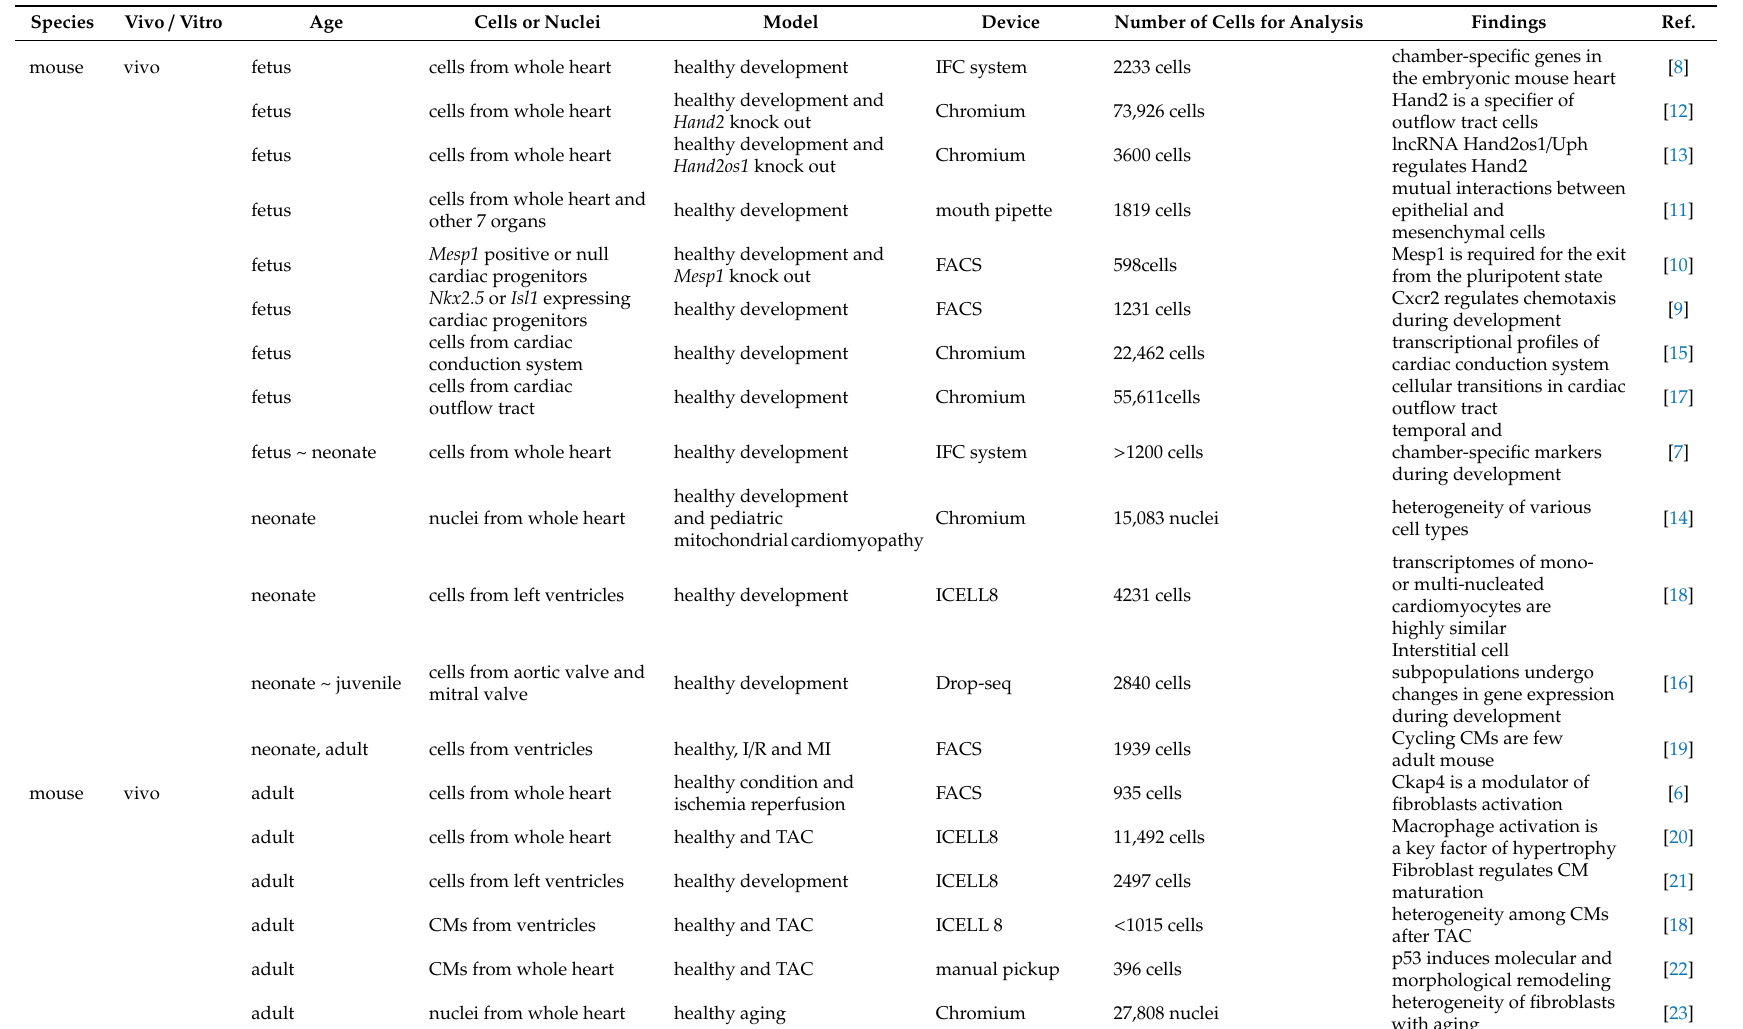
Table 1. Single-cell RNA sequencing in the